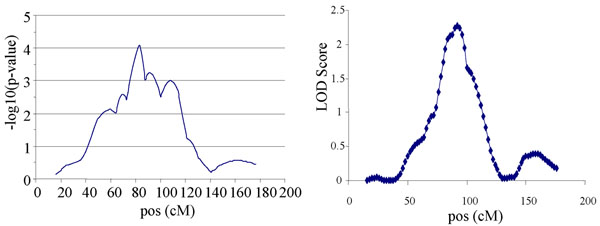
Linkage analysis results for chromosome 9 using the model-free sib pair multi-point regression method of S.A.G.E. (left panel) and the variance component method of GENEHUNTER (right panel).